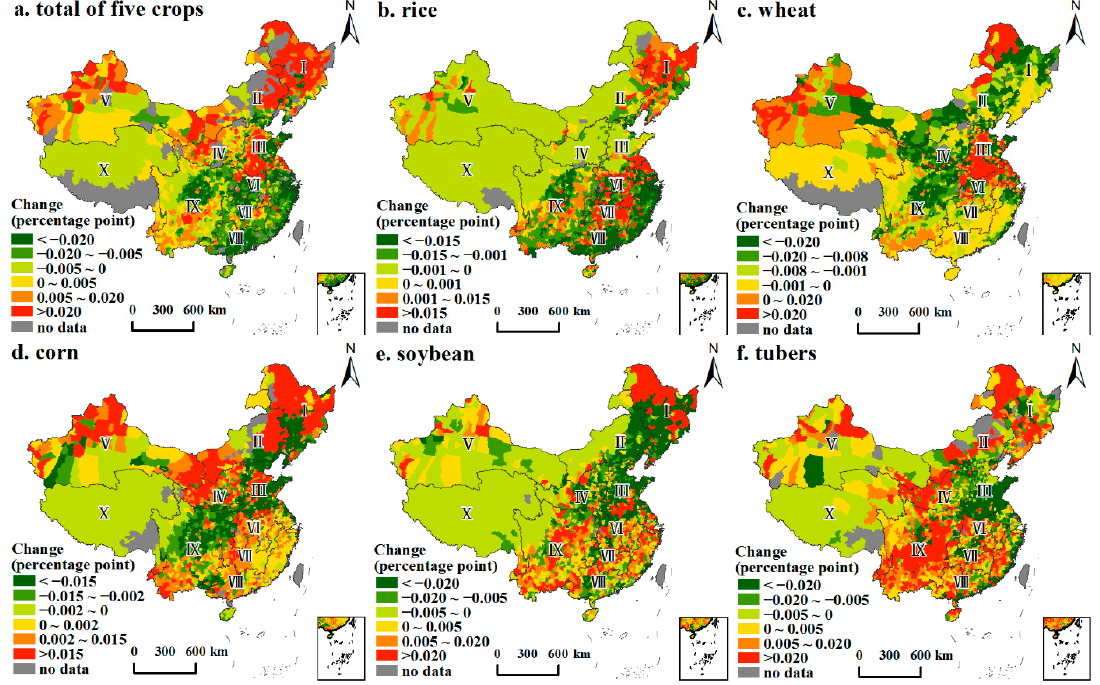
Figure 3. Spatial distribution of crop production changes in the period 1990–2015.